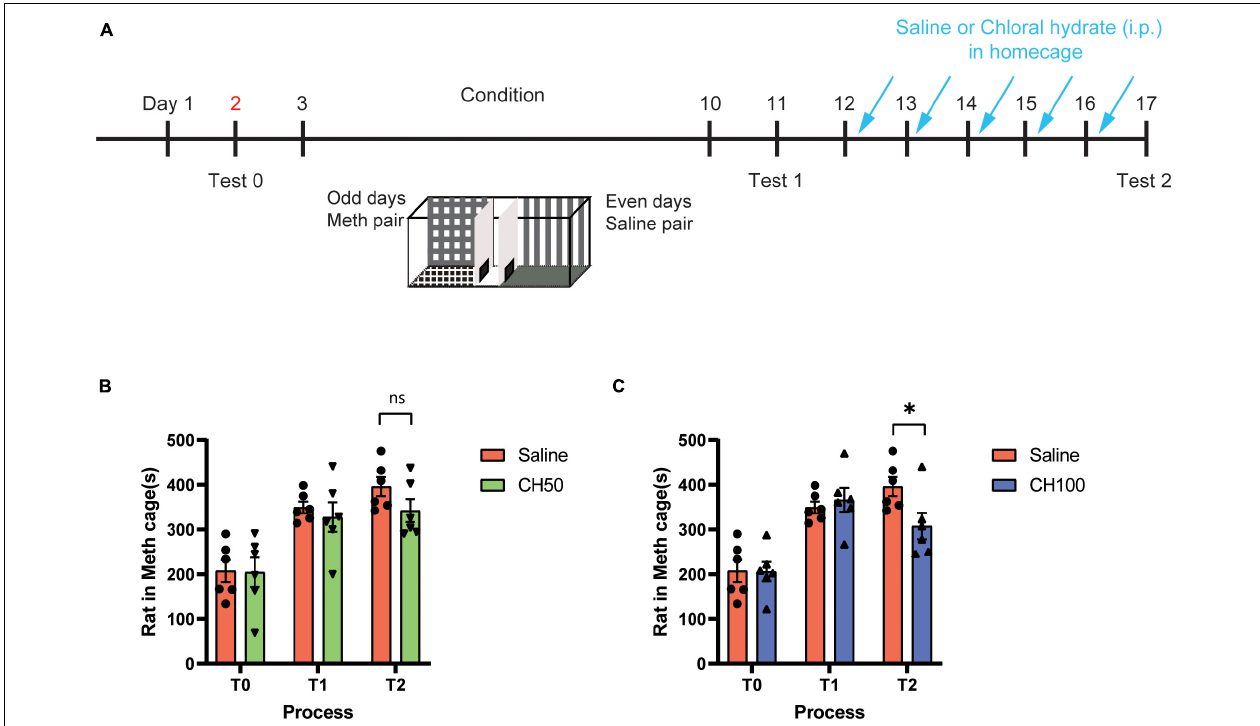
FIGURE 1 | Chloral hydrate reduces Meth-induced CPP maintenance. (A) Representation of rat CPP schedule. Three-chamber system was adopted. (B) The effect of 50 mg/kg CH treatment ( N = 6) on the maintenance of Meth-associated CPP memory. (C) The effect of 100 mg/kg CH treatment ( N = 6) on the maintenance of Meth-associated CPP memory. ∗ p < 0.05, ns: no significant difference. T0: test 0, T1: test 1, T2: test 2.